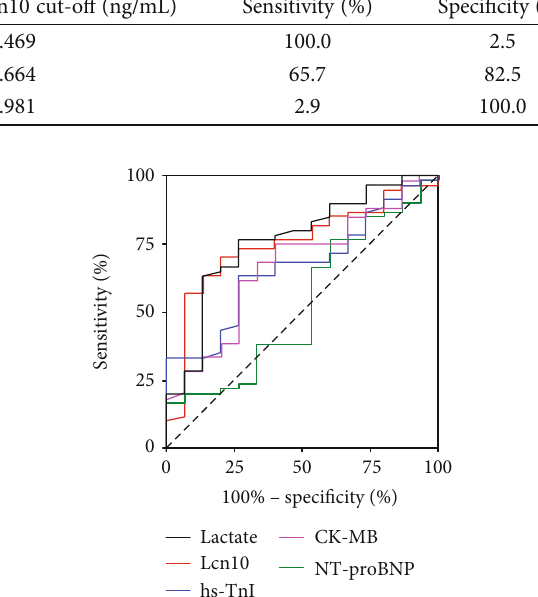
Figure 3: Predictive performance of Lcn10 in 28-day mortality of SIMD patients. Compared to other commonly used biomarkers, ROC curves showed that Lcn10 is a more powerful predictor for 28-day mortality of SIMD patients. The AUC was 0.753 ( P = 0 : 003 ; 95% con fi dence interval,